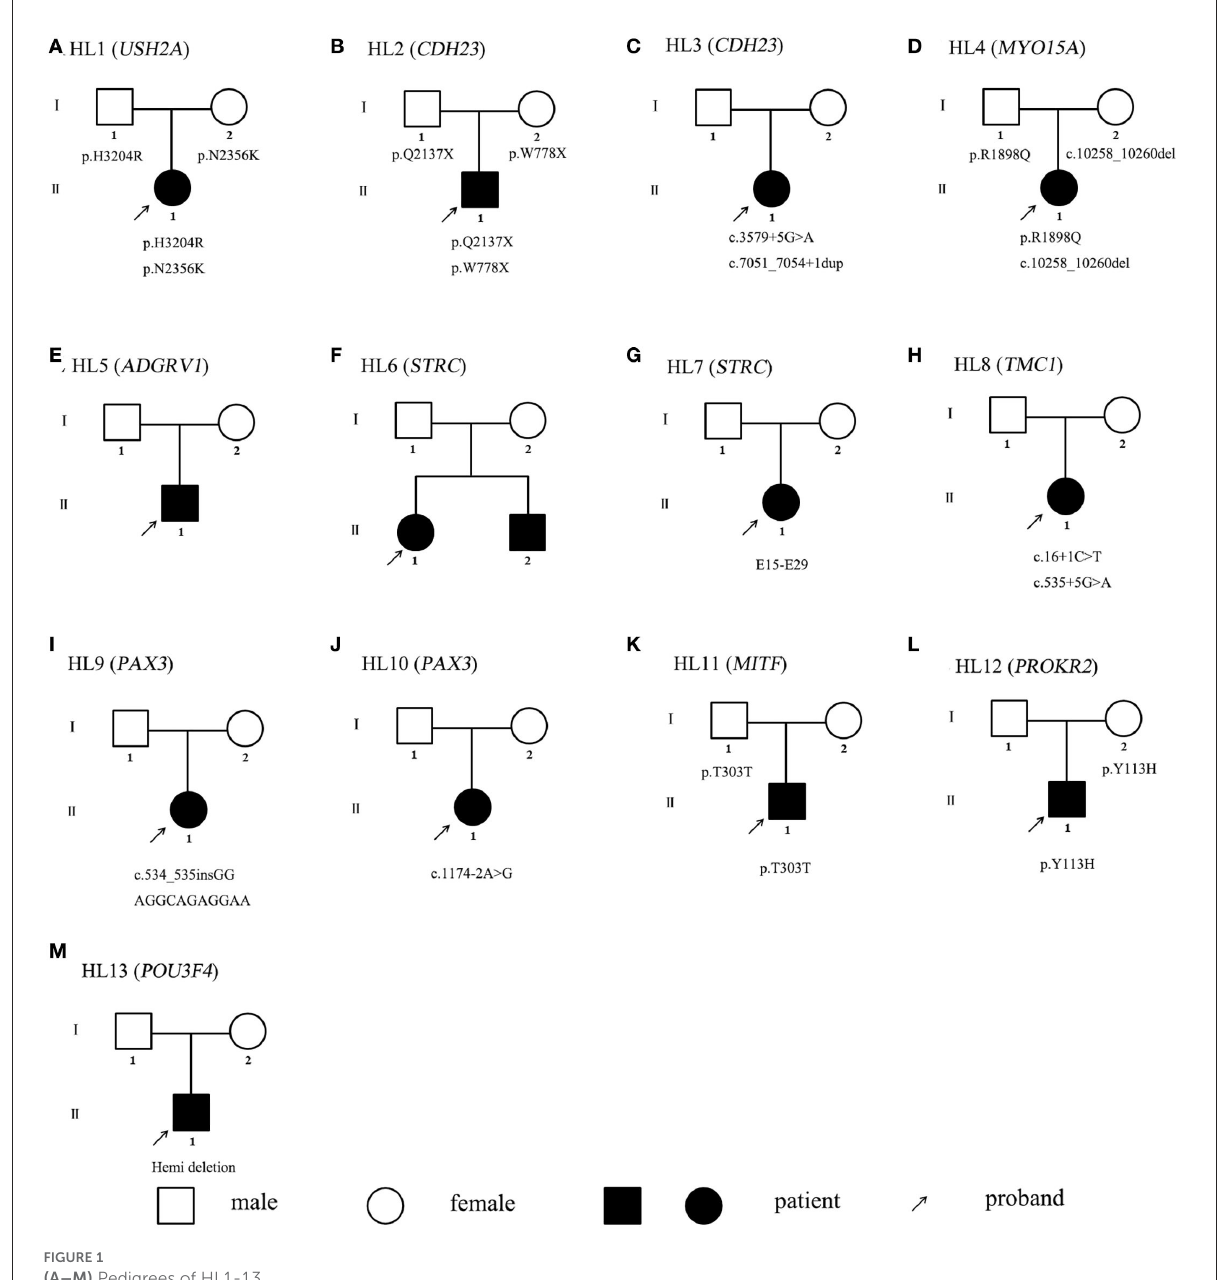
FIGURE1 (A–M) Pedigrees of HL1-13.